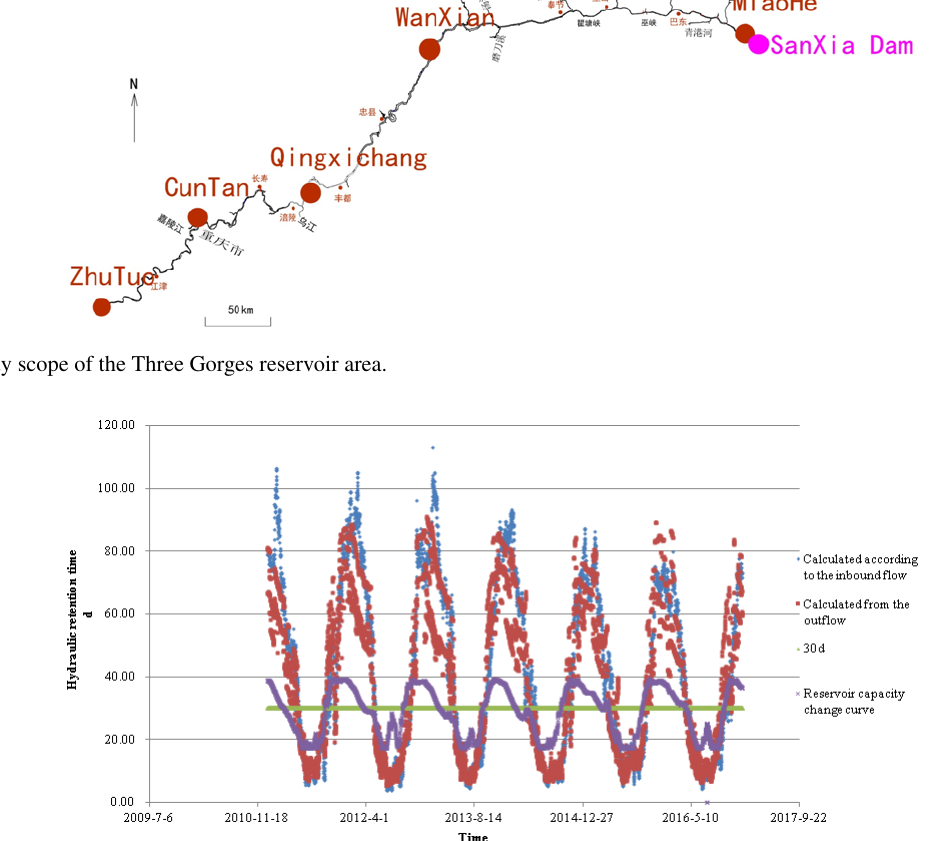
Figure 2. Hydraulic retention time of the Three Gorges Reservoir during